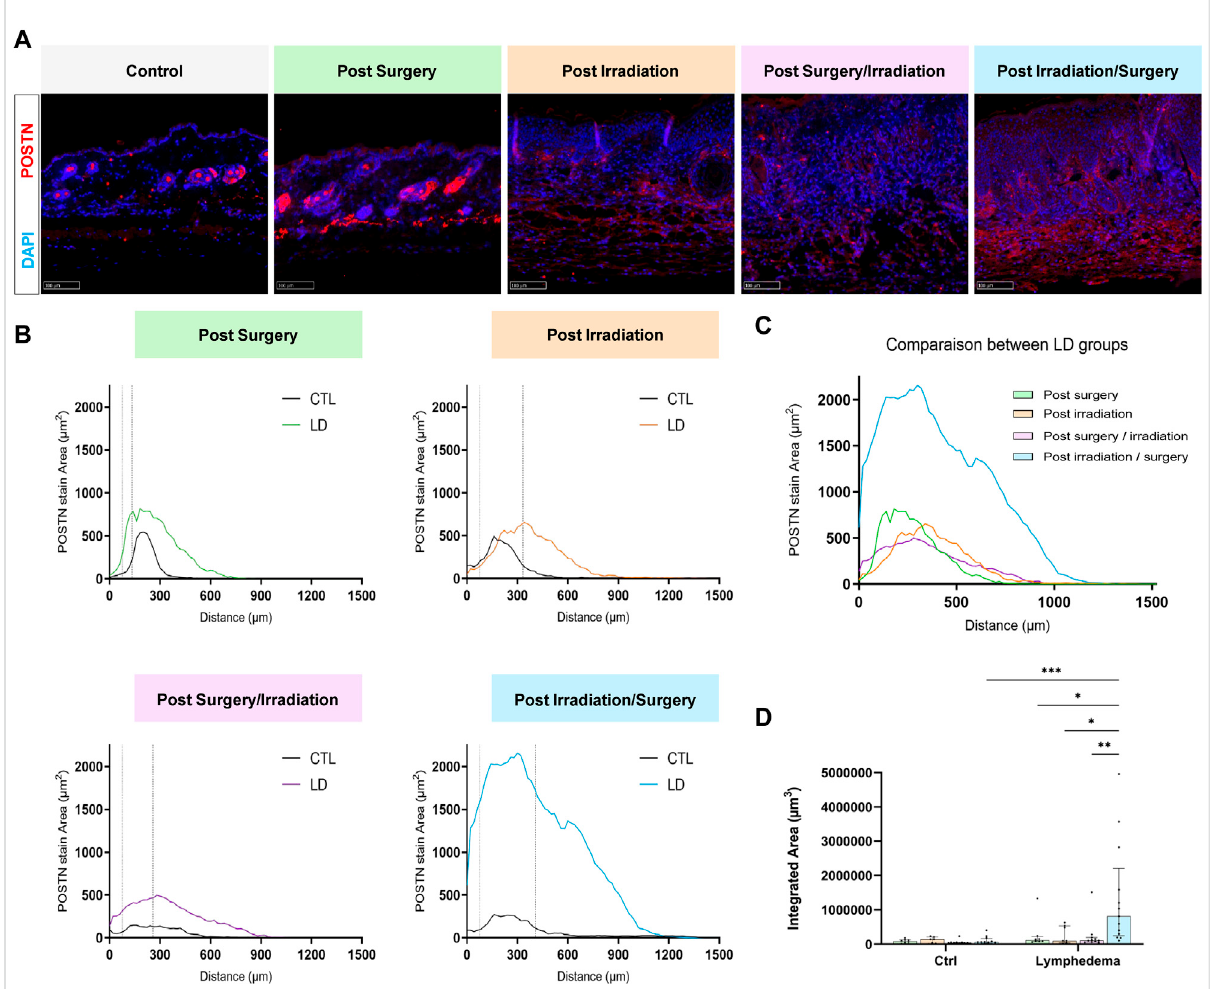
FIGURE 6 Impact of the procedures on POSTN deposition. (A) Representative images of POSTN area staining in control and LD skins (Scale bar: 100 µm). (B) Distribution curves of POSTN ( X axis correspond to the distance from the epidermis/dermis junction). The dotted line delineates the junction betweenpapillaryandreticulardermis(PDandRD,respectively). (C) ComparisonofthedistributioncurvesofPOSTNstaininginthedifferentgroups. (D) Quanti fi cation of total labeling area in the dermis determined by measuring the area under the distributions curve ( “ Integrated Area ” ) (Statistical test: two-way ANOVA with multiple comparison Turkey ’ s test, p < 0.05: *, p < 0.01: **, p < 0.001: ***, p < 0.0001: